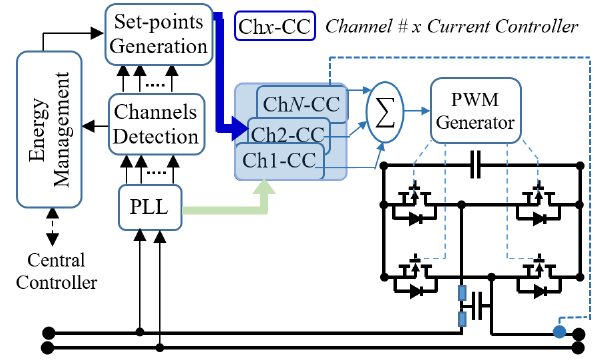
Figure 4. The block diagram of serial compensator control system.